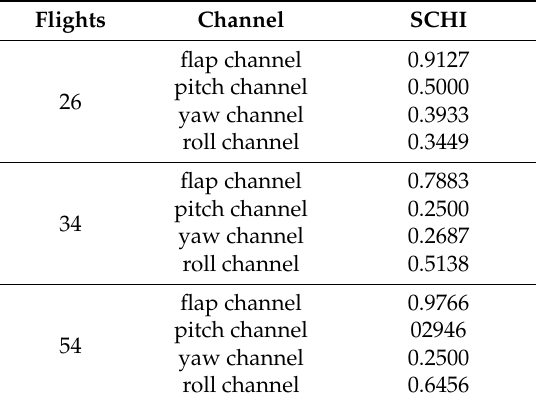
Table 6. SCHI of the 26th, 34th, and 54th sorties.